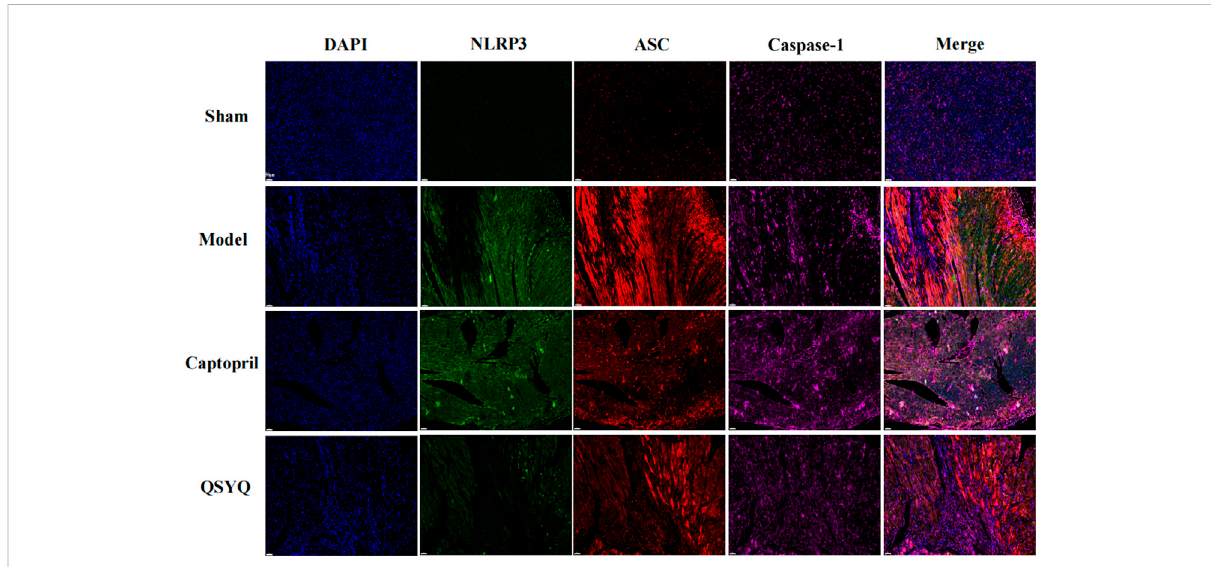
FIGURE 14 Effect of QSYQ on NLRP3 in fl ammasome assembly. Immuno fl uorescence staining was used to observe the co-localization of NLRP3, ASC and Caspase-1 in myocardium. The results showed the co-localization of NLRP3, ASC and Caspase-1 in model group, and the co-localization of NLRP3, ASC and Caspase-1 was signi fi cantly reduced with QSYQ treatment (NLRP3, green; ASC, yellow red; Caspase-1, red; DAPI, blue; Magni fi cation, × 200; n = 4 per